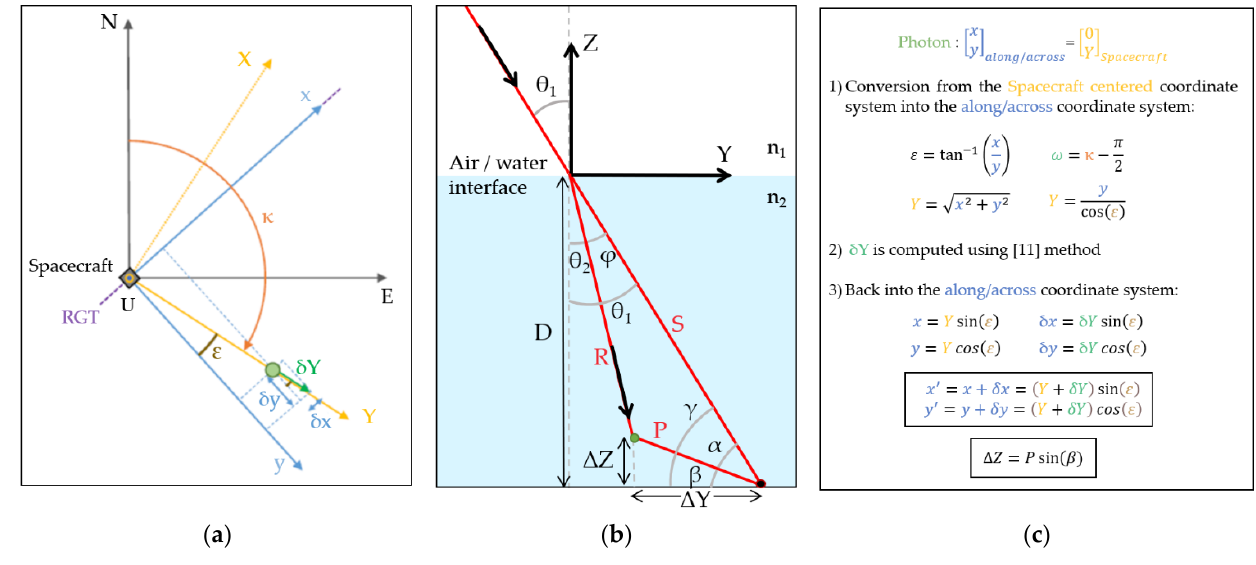
Figure 3. ( a ) Schematic diagram for the change of coordinate systems and the computation of the refraction bias in the horizontal plane; ( b ) in the vertical plane (figure adapted from [21]); and ( c ) correction formulas.